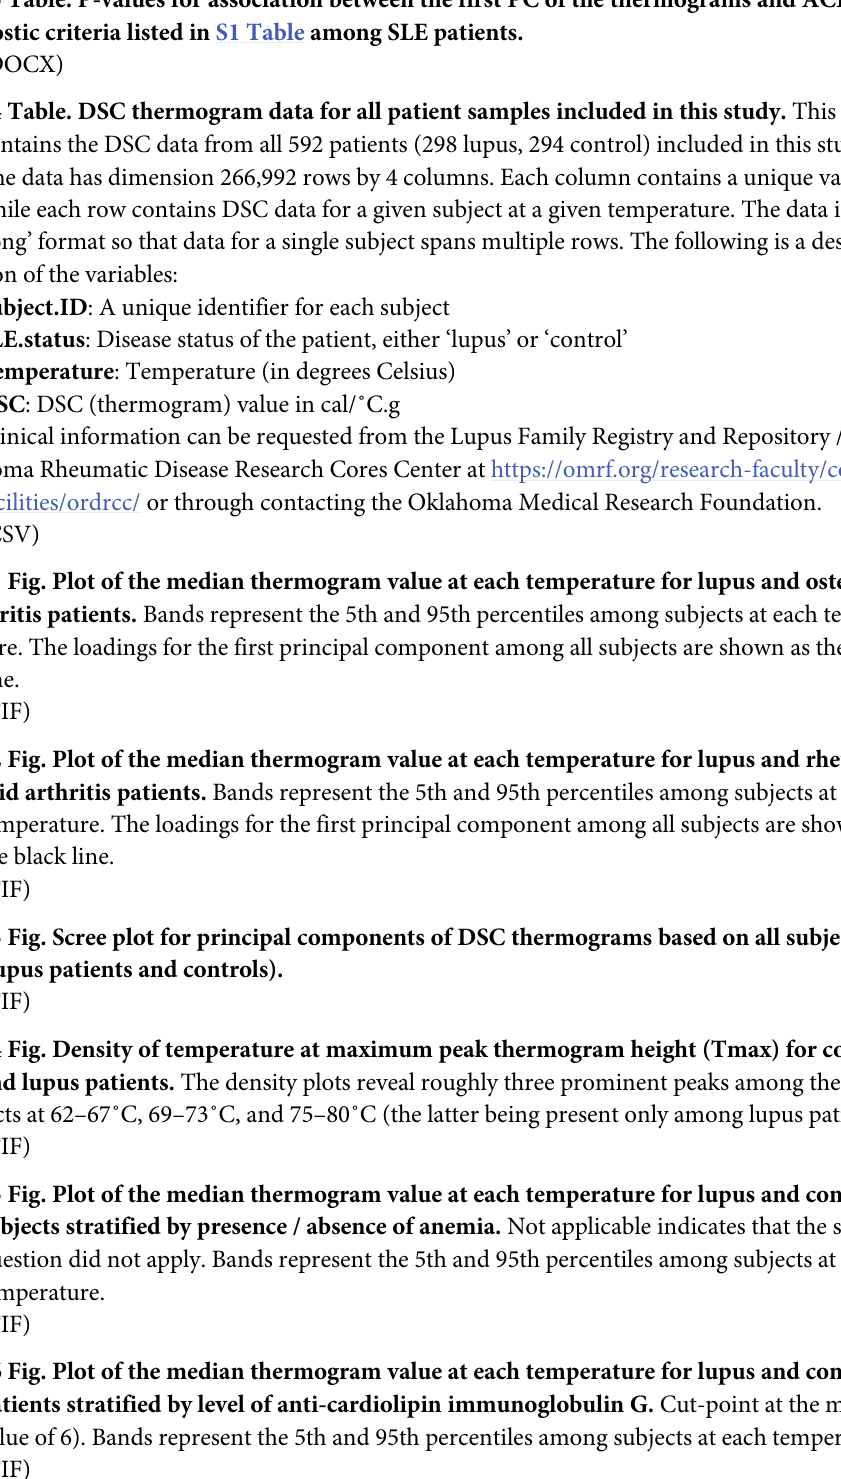
S3 Table. P-values for association between the first PC of the thermograms and ACR diag- nostic criteria listed in S1 Table among SLE patients. S4 Table. DSC thermogram data for all patient samples included in this study. This file contains the DSC data from all 592 patients (298 lupus, 294 control) included in this study. The data has dimension 266,992 rows by 4 columns. Each column contains a unique variable while each row contains DSC data for a given subject at a given temperature. The data is in ‘long’ format so that data for a single subject spans multiple rows. The following is a descrip- tion of the variables: